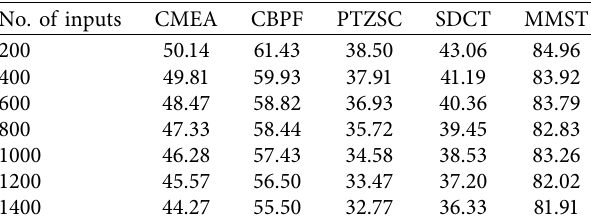
Table 2: Comparison of crop rotation management.